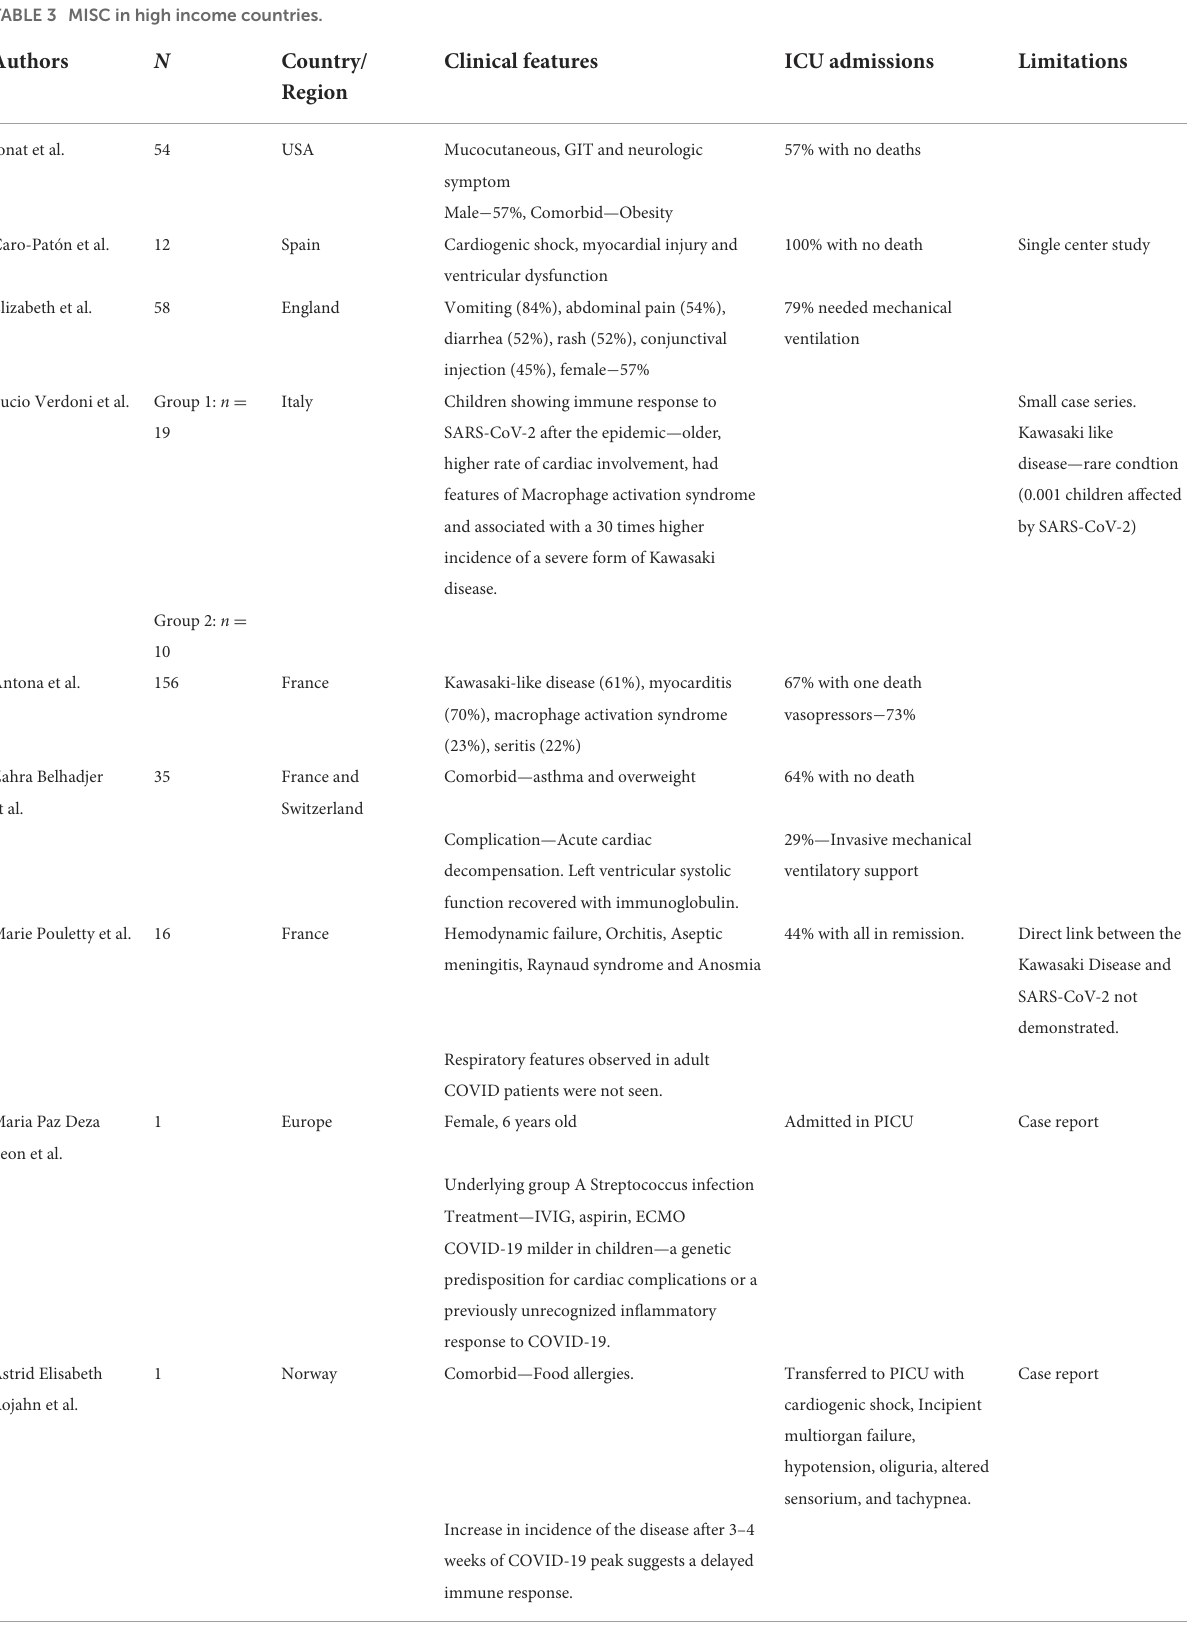
TABLE 3 MISC in high income